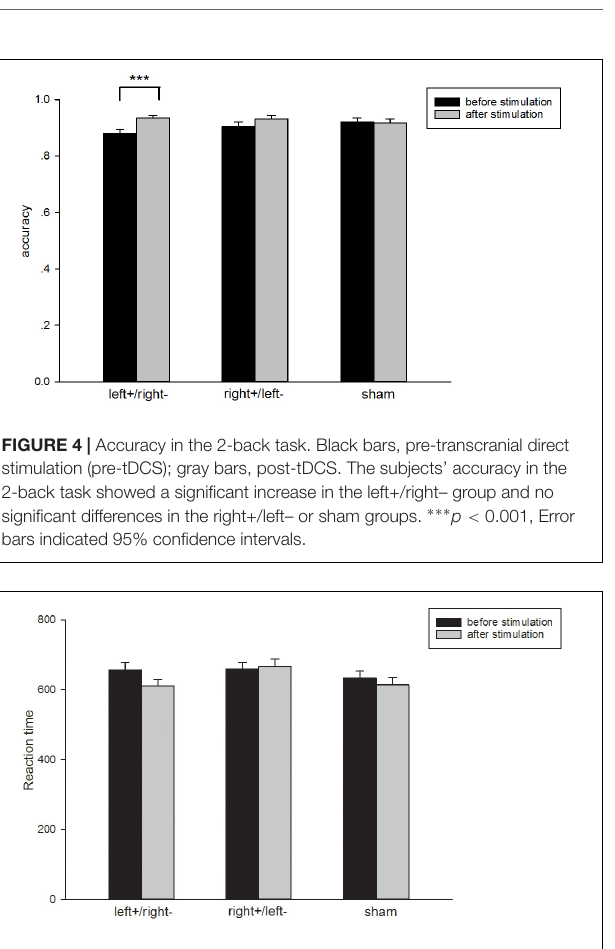
FIGURE 5 | Reaction time in the 2-back task. Black bars, pre-transcranial direct stimulation (pre-tDCS); gray bars, post-tDCS. The subjects’ reaction time in the 2-back task had no significant difference after receiving stimulation. Error bars indicated 95% confidence